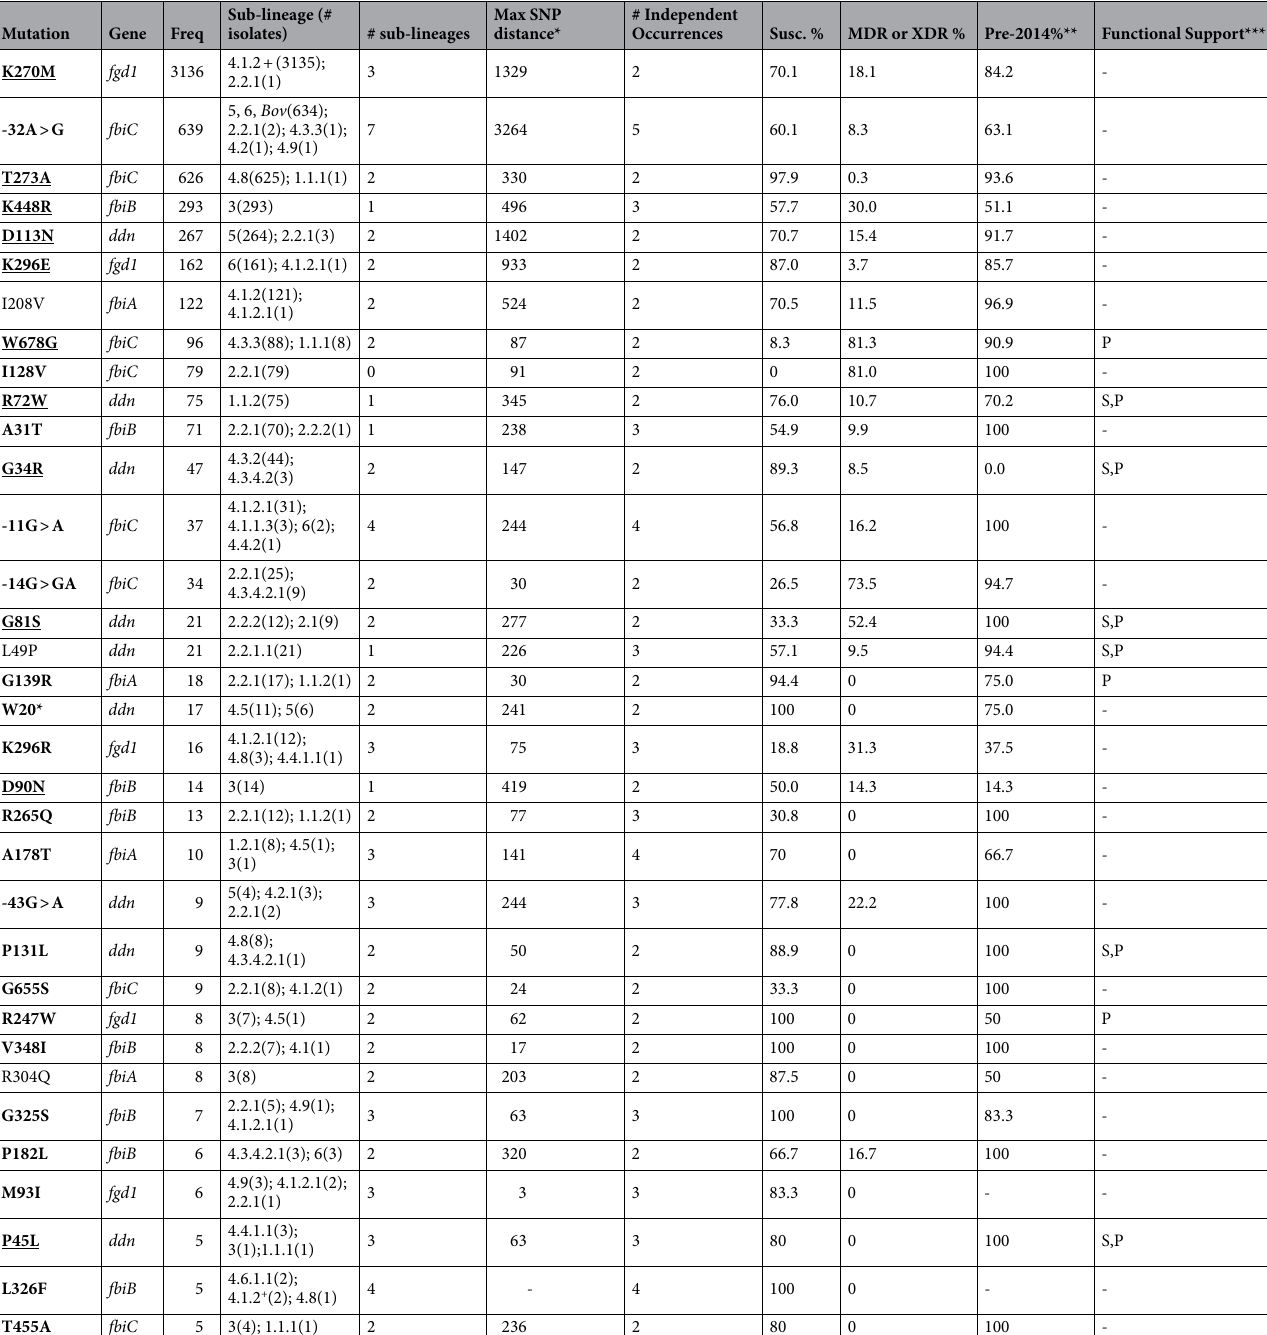
Table 3. Mutations in delamanid candidate genes occurring in at least 5 samples and more than one independent clade. Sub-lineages: + = more than 1 sub-lineage; # = number; * Maximum SNP distance calculated in clades of ≥ 5 isolates; Drug resistance (%): Susc. = Susceptible; ** % of number of samples pre-2014/total number of samples with available collection date; *** Functional support: S = snap2 score ≥ 50; P = Provean Score ≤ −4; M = mCSM predicted stability change (ΔΔG) below − 2; Mutations associated with increased MIC for DLM/PTM in previous studies in bold; mutations associated with susceptibility to DLM/PTM underlined (see S3